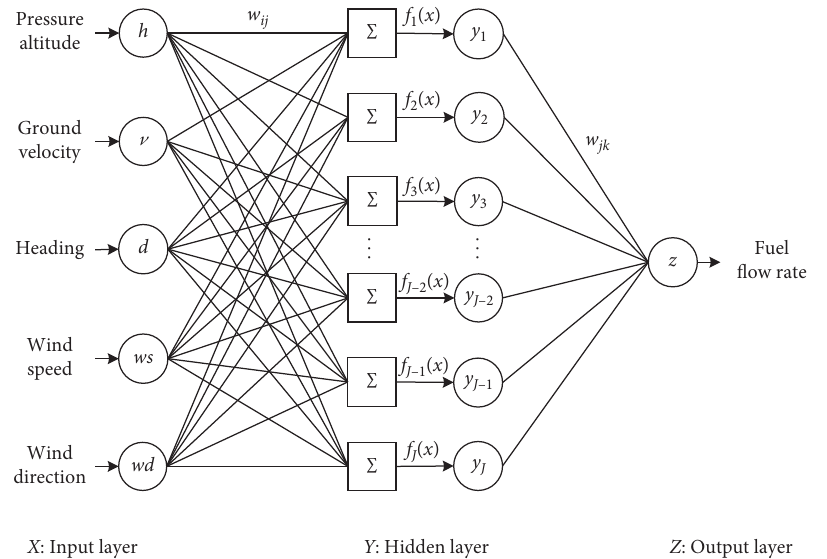
Figure 1: Topology of the WNN for fuel flow